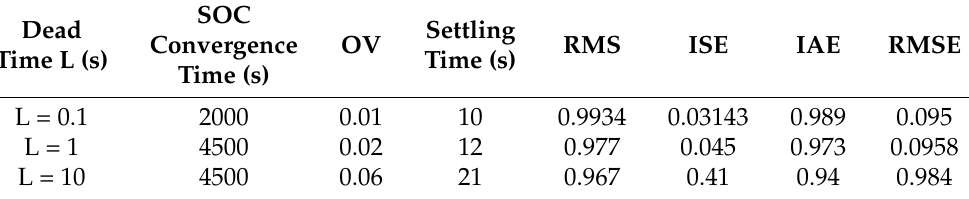
Table 2. SOC benchmark performance